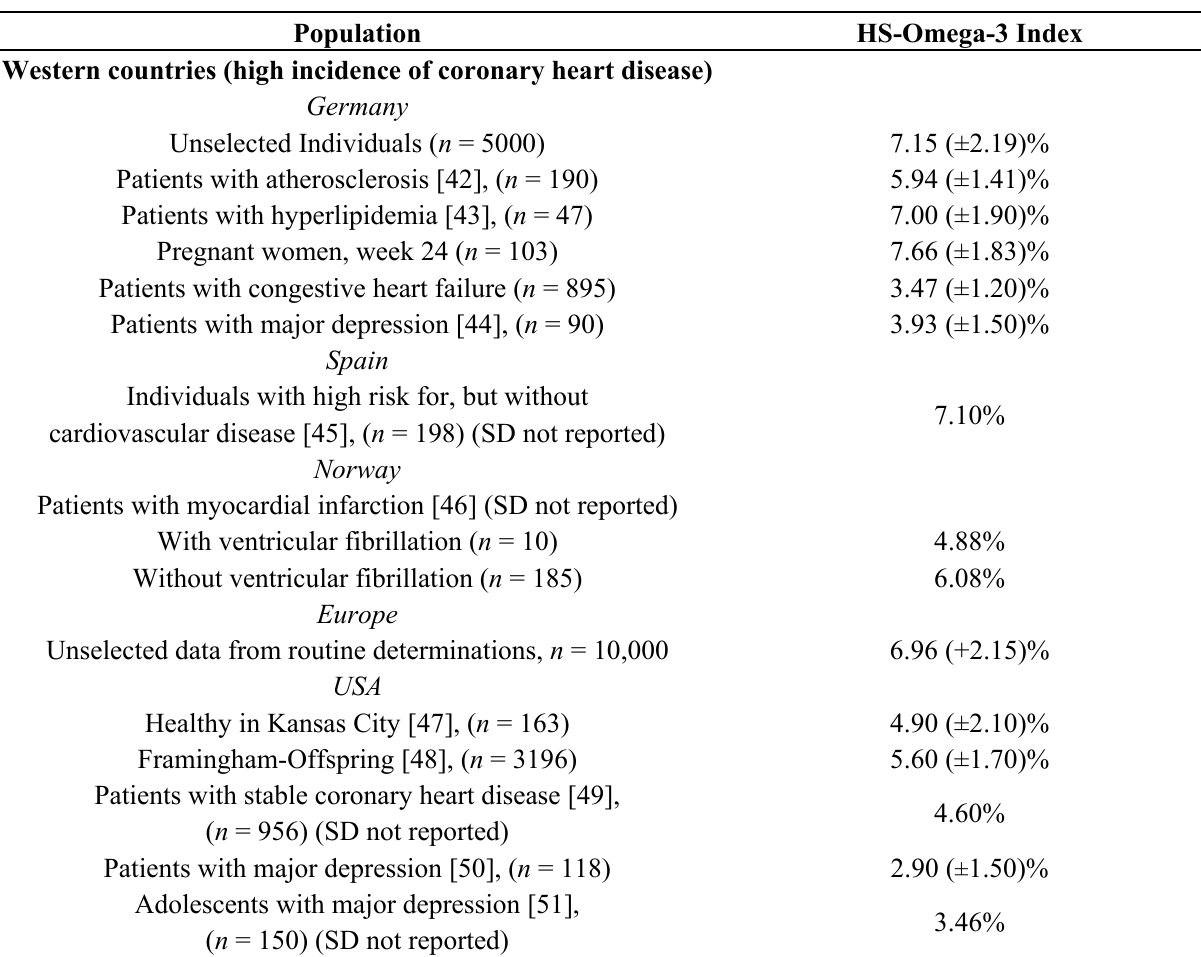
Table 1. Mean HS-Omega-3 Index values in various populations, Mean (±standard deviation (SD)). Please note that in every population studied, a lower value was found to be associated with a worse condition than a higher value. References are given, if not, unpublished, n = number of individuals